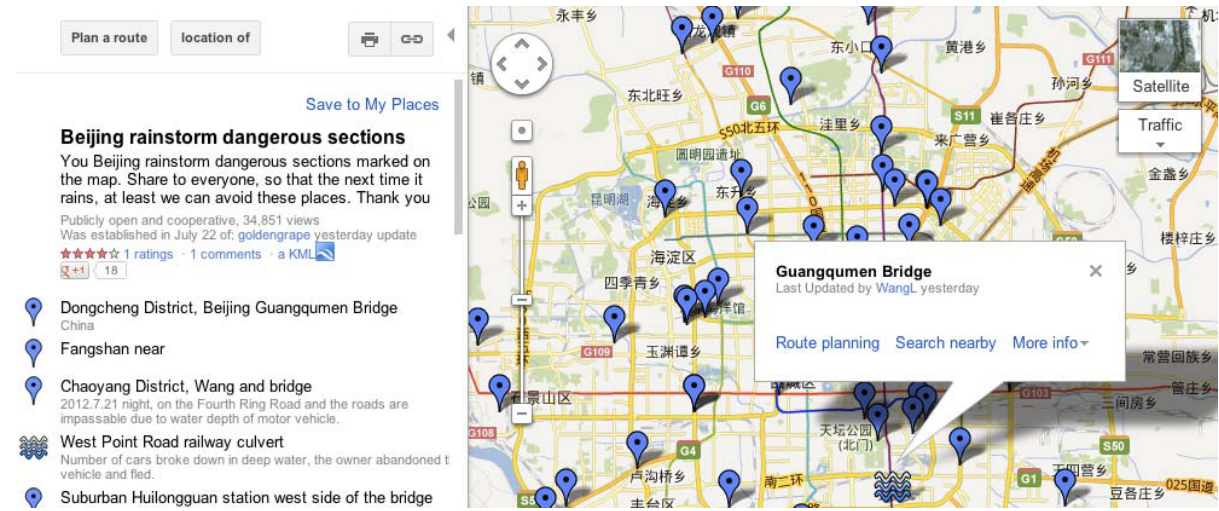
Figure 13: Part of the crisis map made by VGI from the July 2012 Beijing